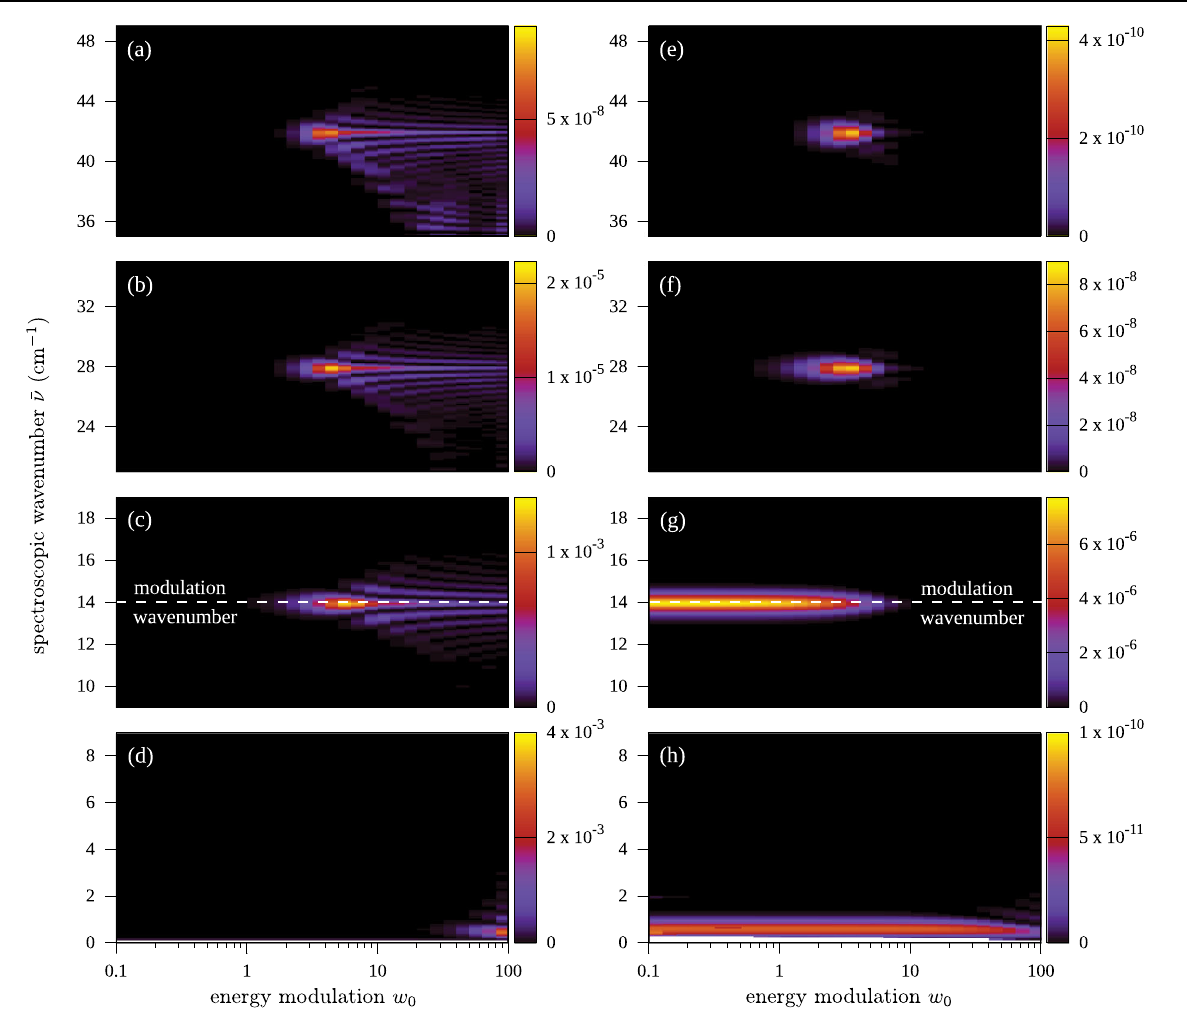
FIG. 8. Form factor versus wave number and energy modulation, for a modulation wave number k m ¼ 272 (i.e., (cid:1) 14 cm (cid:2) 1 ). In the left column we have represented the raw form factor j ~ (cid:2) j 2 . In the right column, we have plotted j ~ (cid:2) j 2 =w 4 0 . With this representation, we can clearly notice the quadratic scaling with laser power [the yellow line of almost constant value in the left part of (g)], expected at low powers [more precisely when w 0 (cid:5) 1 = ð k m r 56 Þ (cid:1) 1 : 26 here]. Note that laser power is proportional to w 2 0 . Parameters are identical to the ones used for Fig. 7 and the experimental results displayed in Fig. 6. For clarity, we have not represented the data in the extremely low wave number part [note that Eq. (7) implies that we must have ~ (cid:2) 2 ð (cid:2) (cid:6) Þ ¼ 1 at (cid:2) (cid:6) ¼ 0 ]. More precisely, the sharp horizontal white regions near (cid:2) (cid:6) ¼ 0 correspond to ~ (cid:2) 2 > 4 (cid:4) 10 (cid:2) 3 in (d), and ~ (cid:2) 2 =w 4 0 > 1 (cid:4) 10 (cid:2) 10 in